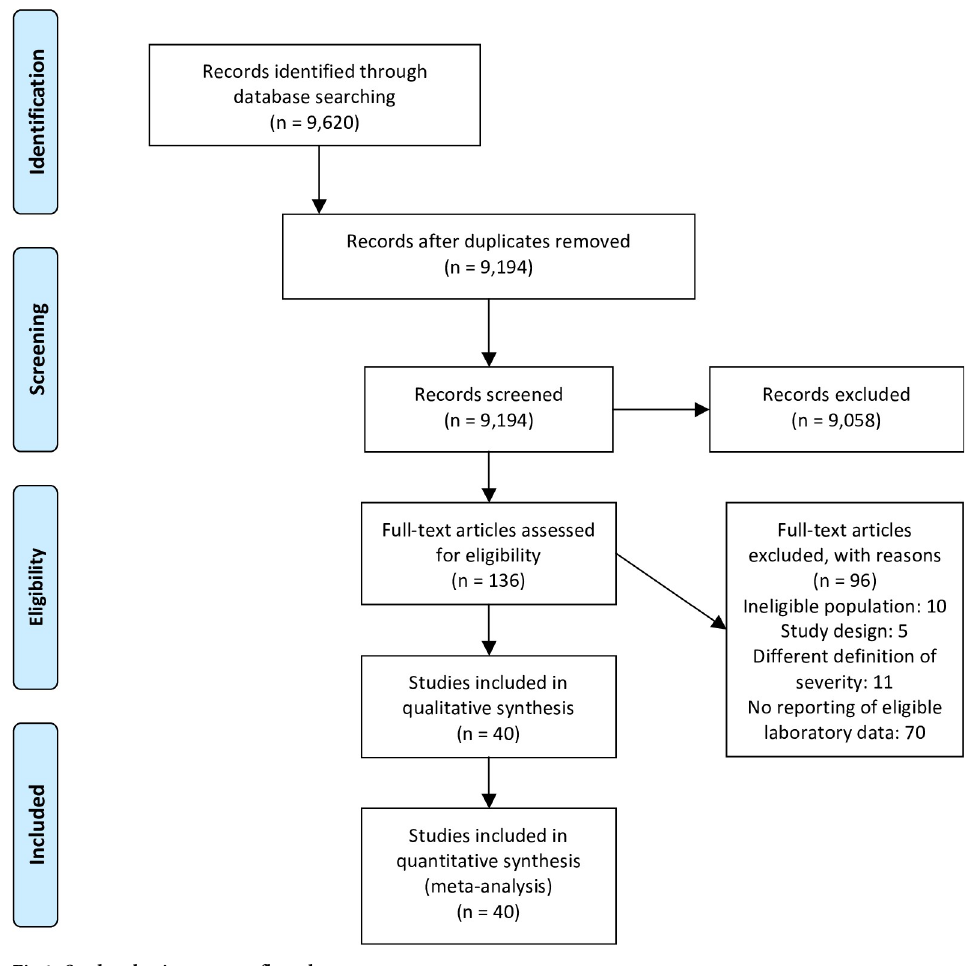
Fig 1. Study selection process flow